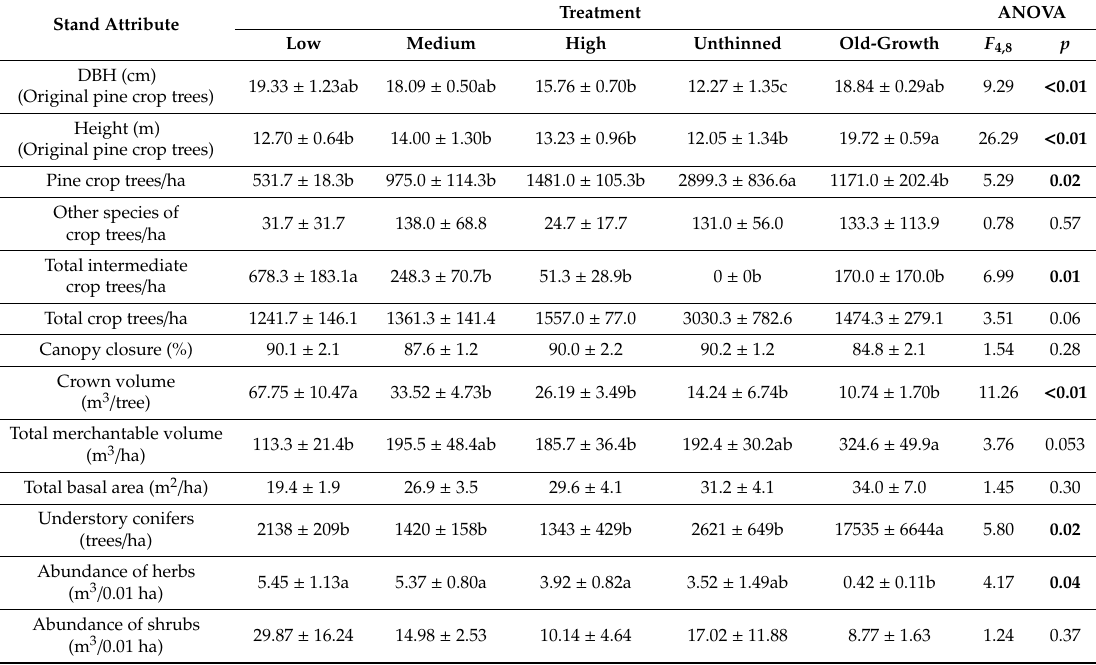
Table 2. Mean ( n = 3 replicate study areas) ± SE 25-year responses (1993 to 2018) of overstory and understory attributes for young lodgepole pine stands with three pre-commercial thinning densities, unthinned, and old-growth treatments at the Penticton, Summerland, and Kelowna areas. Results of analysis of variance (ANOVA) are also provided. Within a row, mean values with di ff erent letters are significantly di ff erent by Duncan’s multiple range test. Significant values in bold